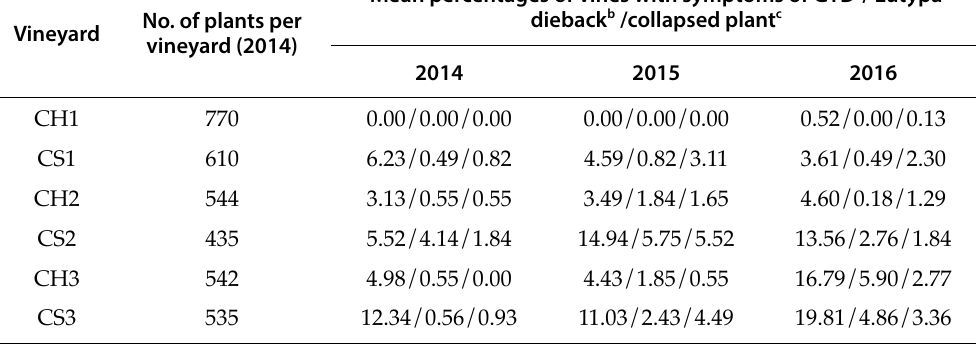
Table 2. Proportions of vines with grapevine trunk disease (GTD) symptoms in six Moravian vineyards during three grow- ing seasons (2014, 2015 and 2016).